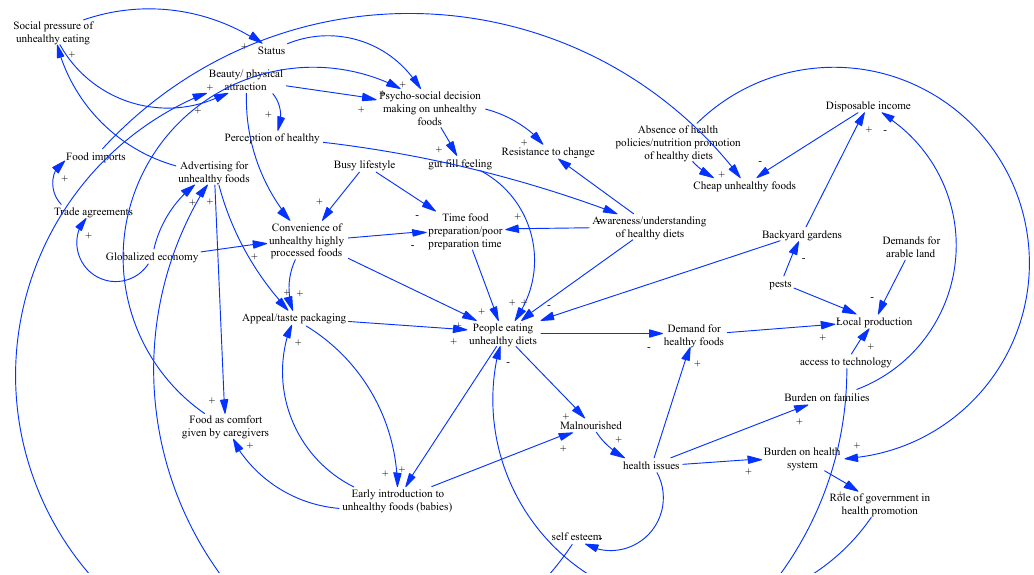
Figure A4. Nevis preliminary causal loop diagram for unhealthy eating. Figure 2b - Nevis preliminary causal loop diagram for unhealthy eating